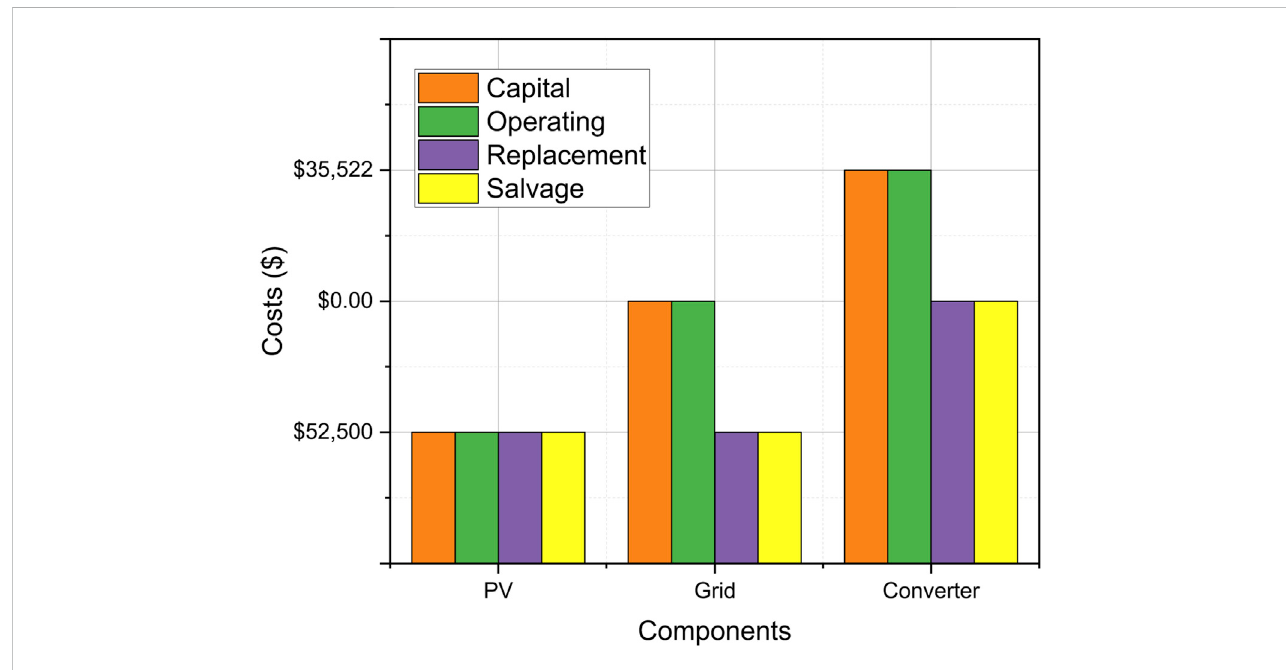
FIGURE 6 Cost analysis of the proposed system.